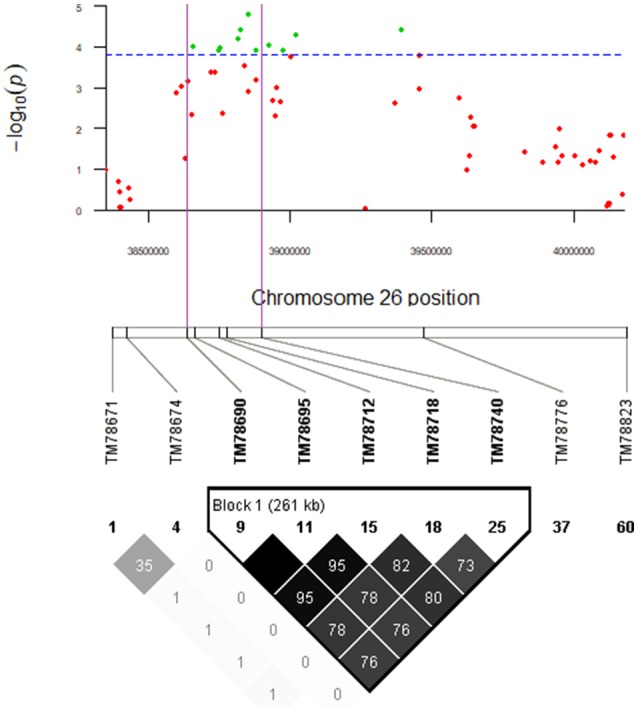
qGhPR-c26 on Chr26 (D12: 38644336..40094524) was associated with protein content in seed. Manhattan plot shown for the D12: 38644336..40094524 region. The green plot in purple region of Manhattan plot and the bold SNP markers in Block 1 (261kb) were significantly associated with PR.